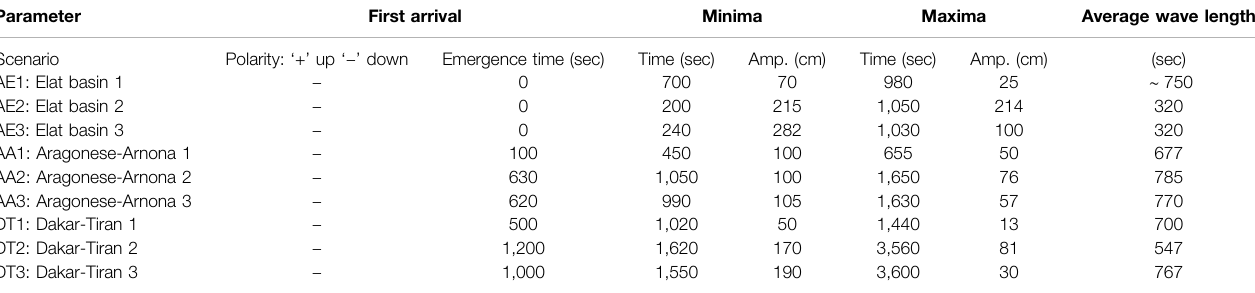
TABLE 4 | Characteristics of the resulting waveforms of the nine worst-case scenarios as recorded by the Elat arti fi cial tide gauge (#10, Figure 5 , lower row).